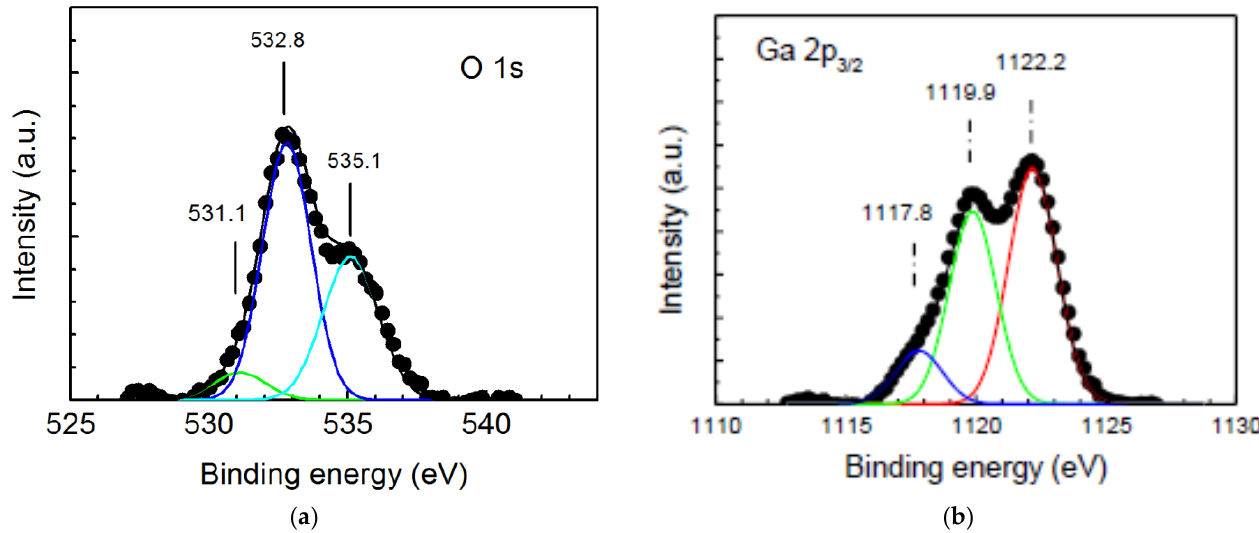
Figure 1. The XPS spectra of ( a ) O 1s and ( b ) Ga 2p 3/2 for sample SP20.